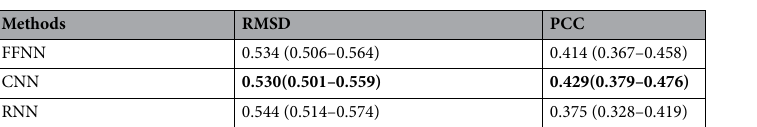
Table 3. ALSFRS slope performance with most important features. RMSD and PCC are shown for all methods. Performance was obtained on the external test set (n = 731) using 10,000 bootstrap with resampling. FFNN was trained using the top 5 features, CNN and RNN were trained using ALSFRS questionnaire data and the top 4 features. The best values for each metrics are in bold.